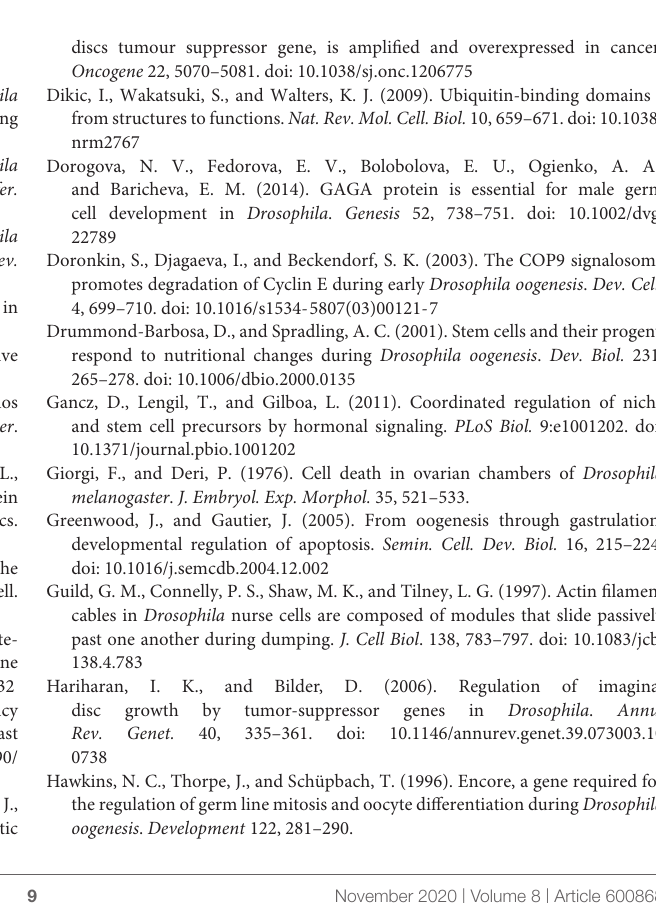
Supplementary Table 1 | ‘Extra round of mitosis’ phenotype manifestations. Supplementary Table 2 | Hyd interacting